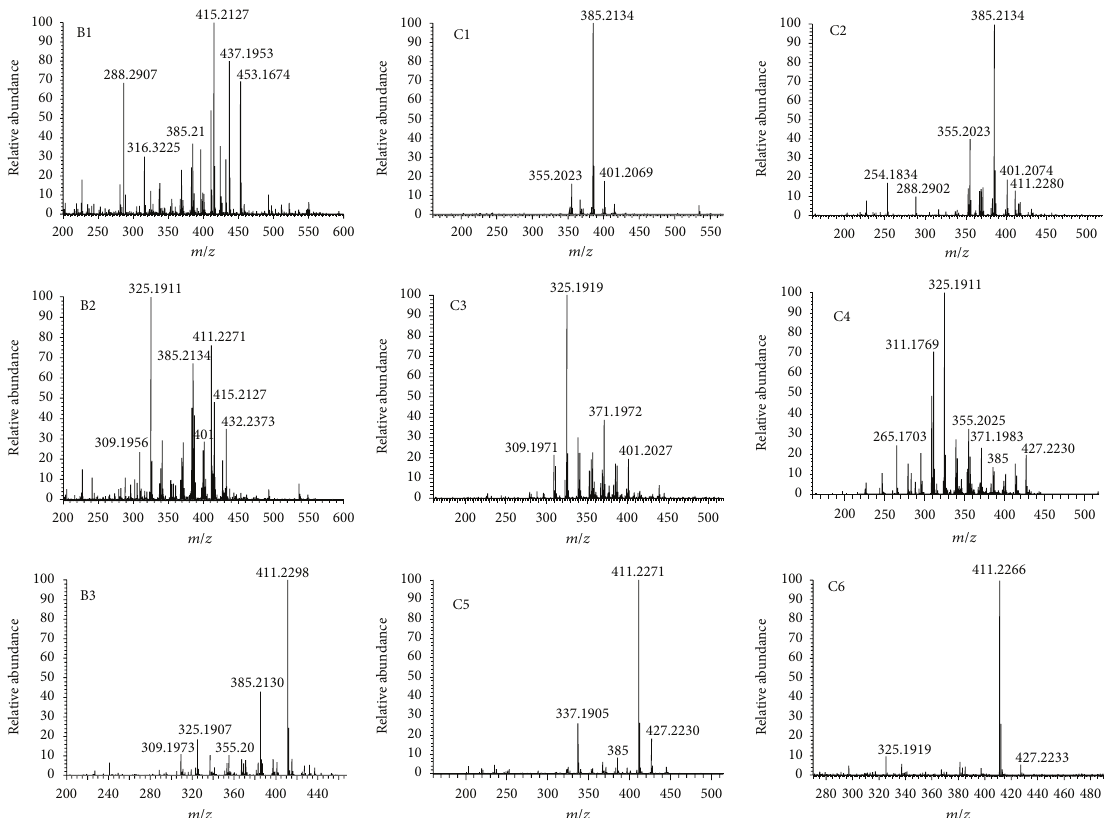
Figure 4: 2 Electrospray positive spectra of fractions B1–B3, C1–C6.